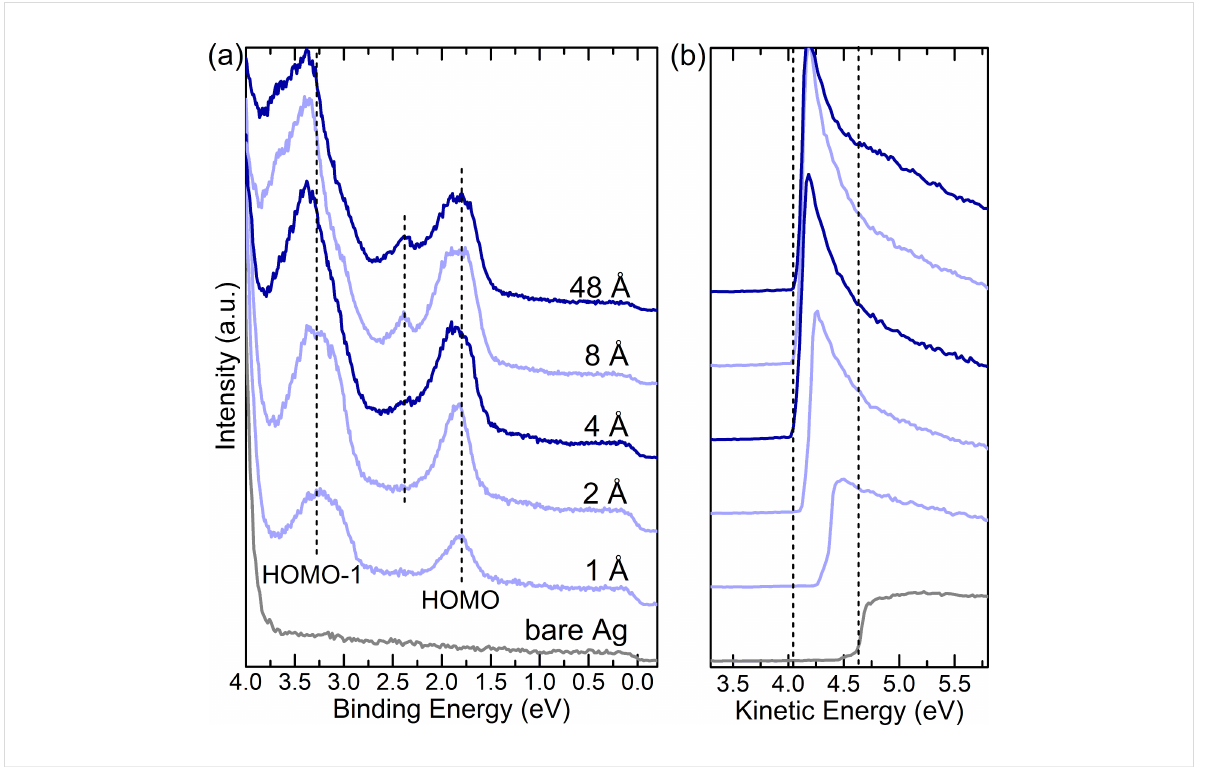
Figure 2: Valence band (a) and secondary electron region (b) of the UPS spectra of F4PEN on Ag(111). In (a), the nominal mass thickness is denoted.